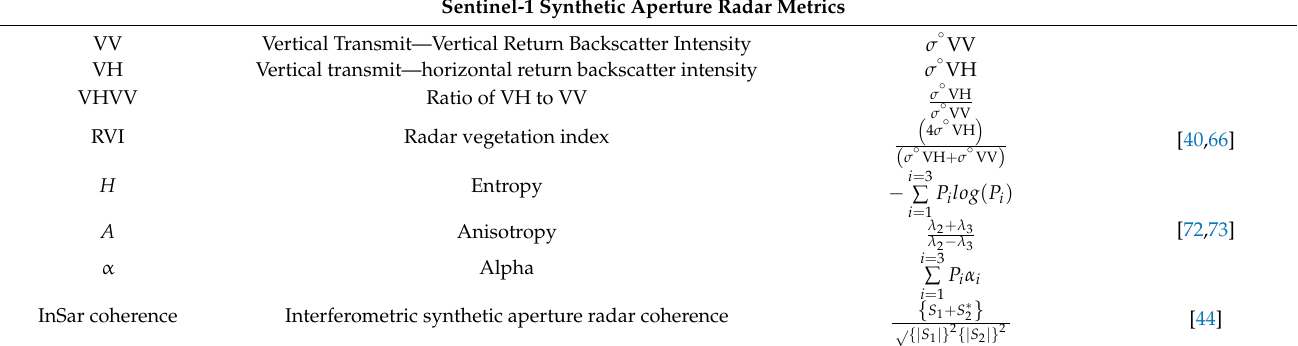
Table 2. Sentinel-1 synthetic aperture radar (SAR) backscatter, polarimetric, and phase parameters where σ ◦ indicates backscatter intensity per unit area, Pi represent the probabilities from the eigenval- ues in the polarimetric decomposition, λ is the non-negative real eigenvalues of the diagonal matrix, alpha is the alpha angle, entropy ( H ) and anisotropy ( A ) are additional output parameters from the polarimetric decomposition, and InSAR coherence from an analysis in which the first and second scene are denoted as S 1 and S 2 ,